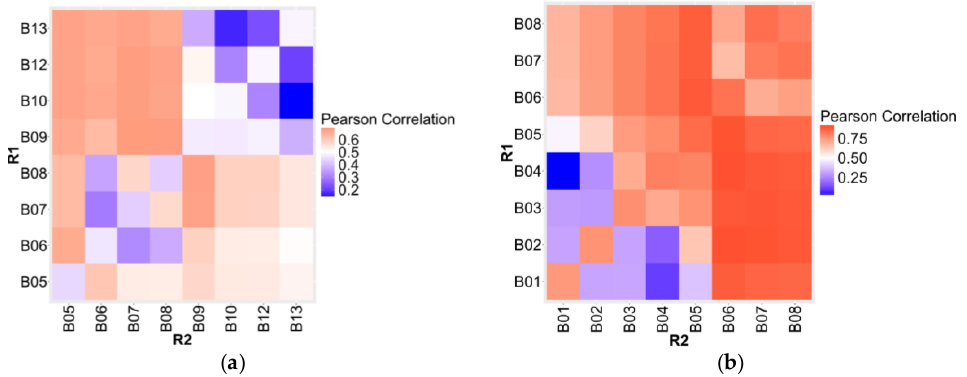
Figure 4. Correlation coefficients between MERIS atmospherically corrected reflectance ratio and in situ chl-a ( a ) and between MERIS atmospherically corrected reflectance ratio and in situ SDD ( b ) R1 and R2 represent nominator and denominator, respectively. Values along the diagonal line from lower left to top right indicate correlation with reflectance of a single